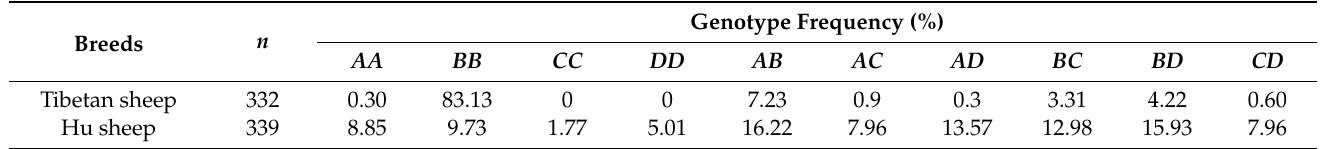
Table 4. The effect of breed and gender on blood gas.